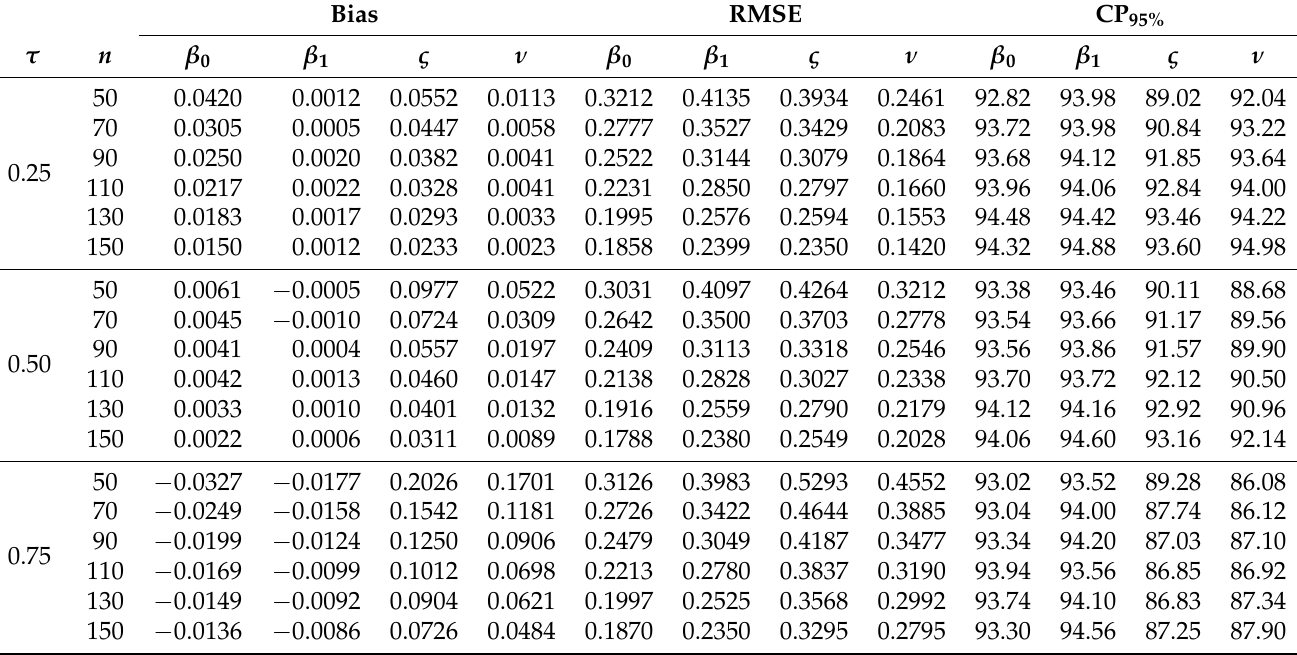
Table 3. Empirical RMSE, bias, and 95% CP (true values: β 0 = 0.50, β 1 = 0.50, ς = 0.50, and ν = 1.00) of the ML estimator for the indicated parameter with simulated data.